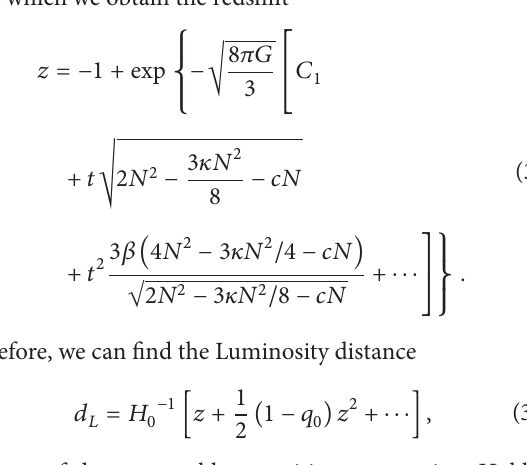
Figure 2: Evolution of 𝜔 with potential (38) as a function of time. For the numerical analysis we assume 𝑁 = 3 , 𝑐 = 3 , and 𝛽 = 1 . From